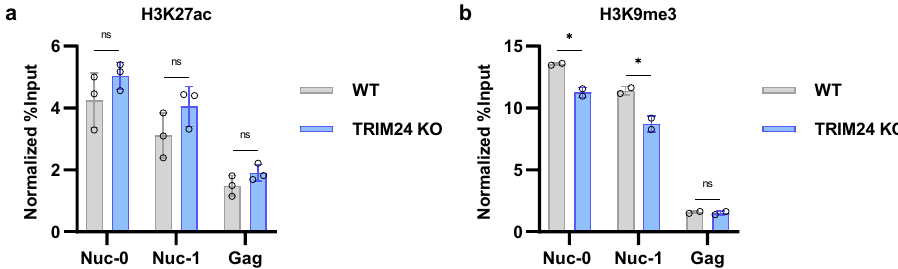
Fig. 8 Loss of TRIM24 does not induce restrictive LTR chromatin organization. a , b Wild-type or TRIM24 KO Jurkat mHIV-Luciferase cells were subject to ChIP-qPCR using antibodies targeting acetylated H3K27 ( a ) or trimethylated H3K9 ( b ). ChIP-qPCR results were normalized by subtraction of values produced with sample-paired non-speci fi c IgG ( n = 2 – 3, mean ±